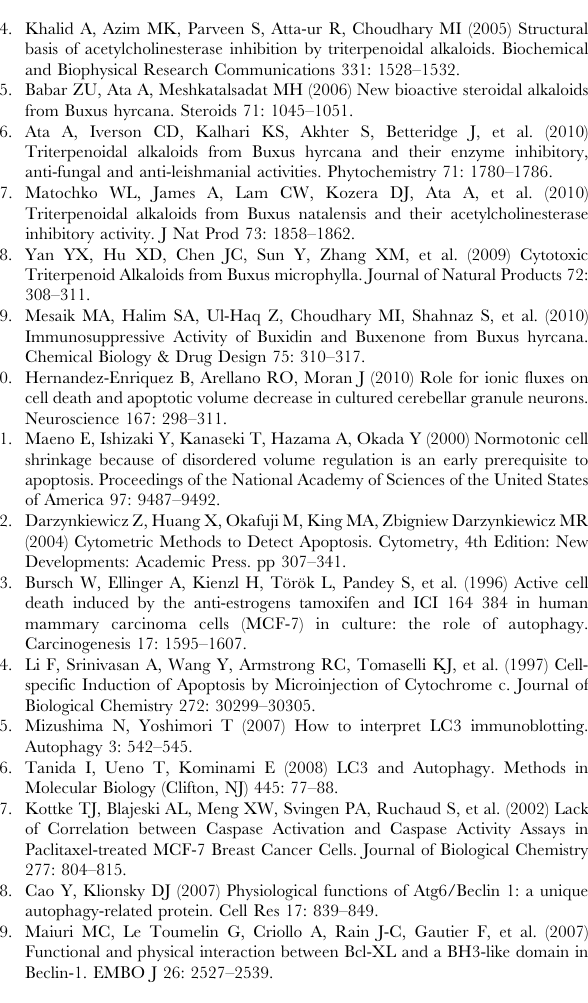
Figure S4 Treatment of T47D and BT-20 cells with the plant extract resulted in the accumulation of apoptotic/ necrotic cells. A. T47D cells were treated during 24 h and 48 h with the plant extract (IC 50 ) and resulted in the accumulation of apoptotic/necrotic cells as illustrated with the Annexin V-FITC stained cells analyzed by FACS. B. Annexin V-FITC stained BT- 20 cells showing that after 24 h of plant extract treatment (IC 50 ), there is an emergence of pre-apoptotic cells that shift to apoptotic/ necrotic cell population after 48 h of treatment. Figure S5 Buxus extract treatment in T47D and BT-20 cells resulted in autophagy. A and C. Immunofluorescence targeting LC3 obtained with untreated and treated T47D and BT- 20 cells, respectively, (IC 50 , 72 h), showing the punctuated staining of the processed form LC3 II. Magnification 6 400. Ac Bux: acetonic Buxus extract. B and D. Immunoblots of total cell extracts of untreated and treated T47D and BT-20 cells,